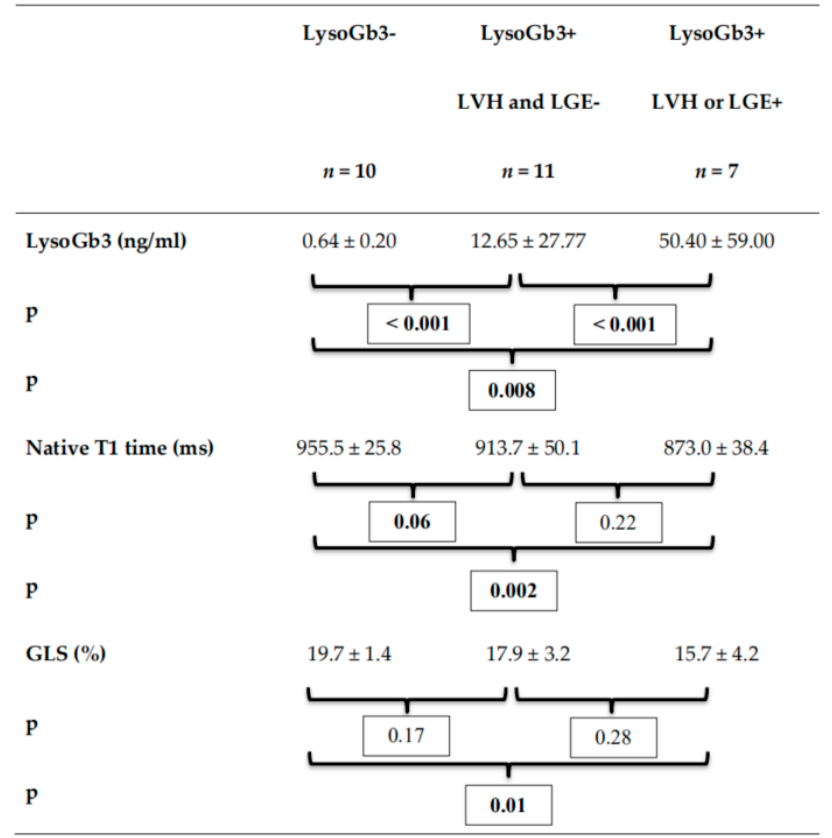
Figure 5. LysoGb3, septal native T1 and GLS in FD subgroups. GLS—global longitudinal